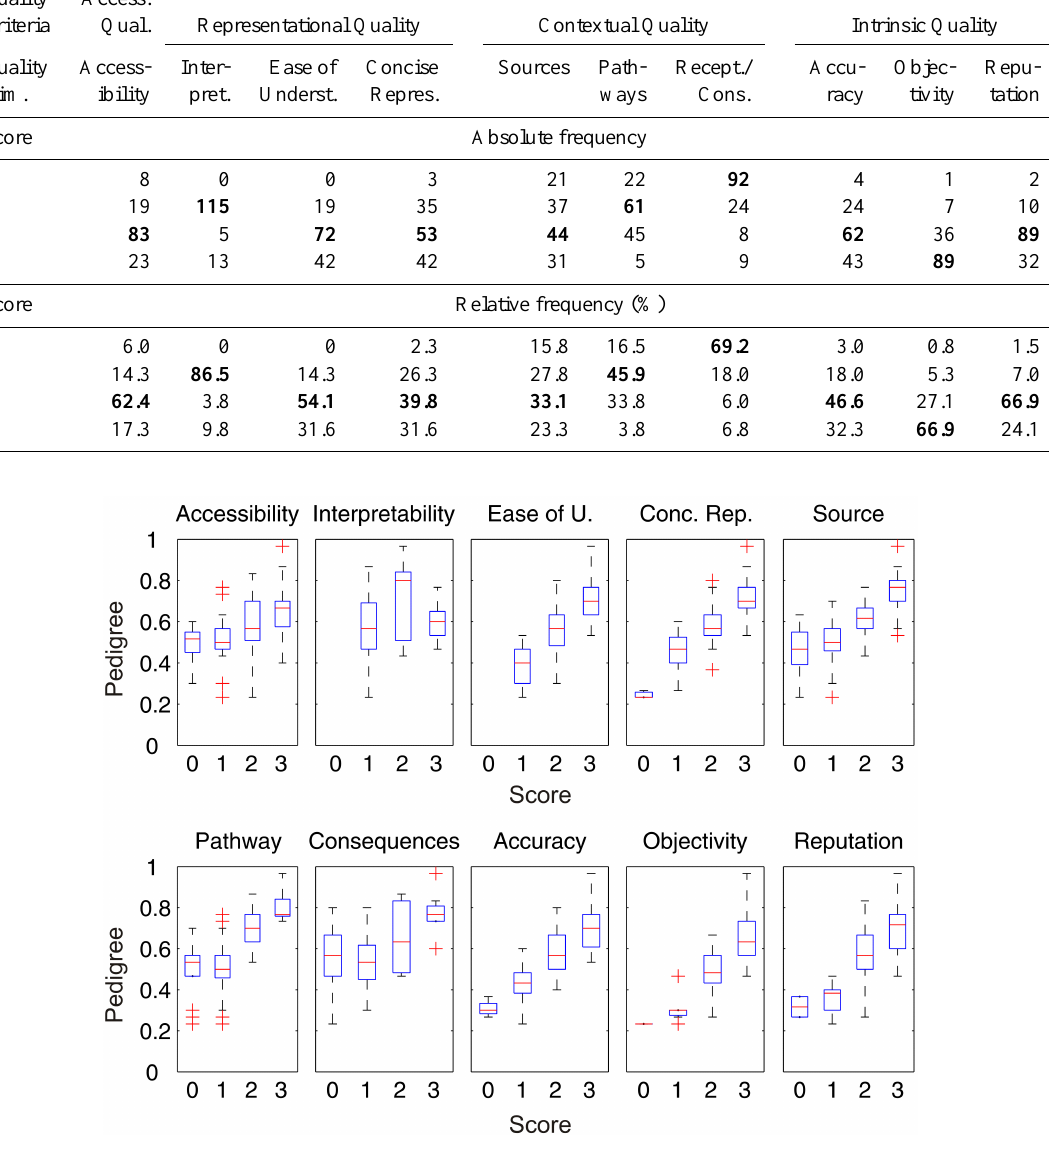
Fig. 4. Boxplots showing the distribution of the overall pedigrees reached by the documents in a particular score class of a quality dimension. The sample size per box can be inferred from Table